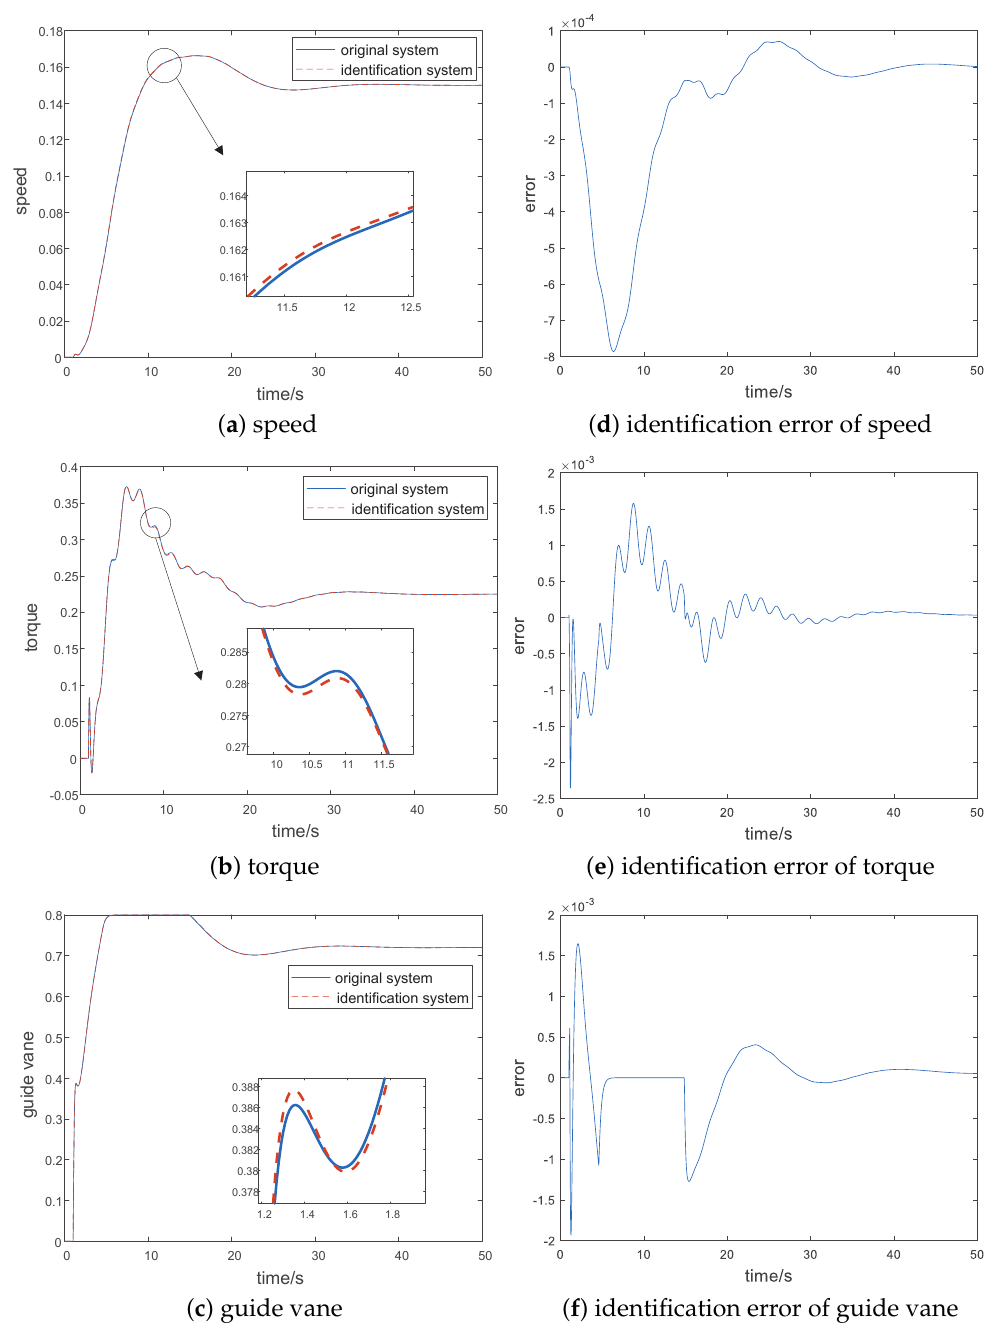
Figure 9. Comparison between the outputs of the three parts of the original and the identification systems under a 15% frequency